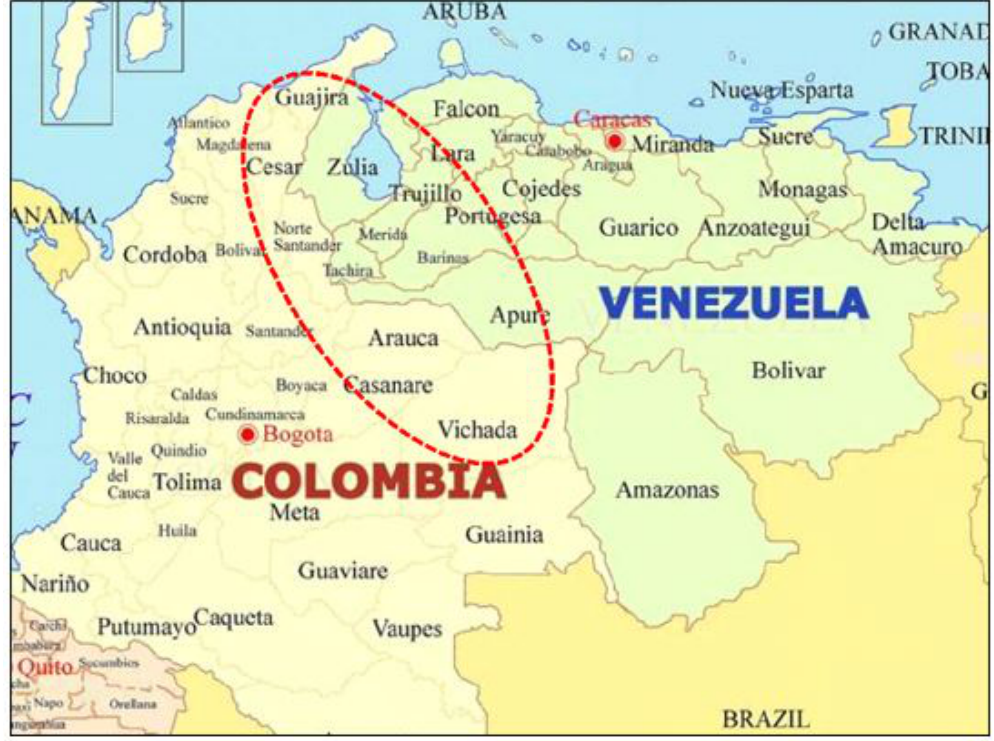
Figure 4. Political map of the border between Colombia and Venezuela